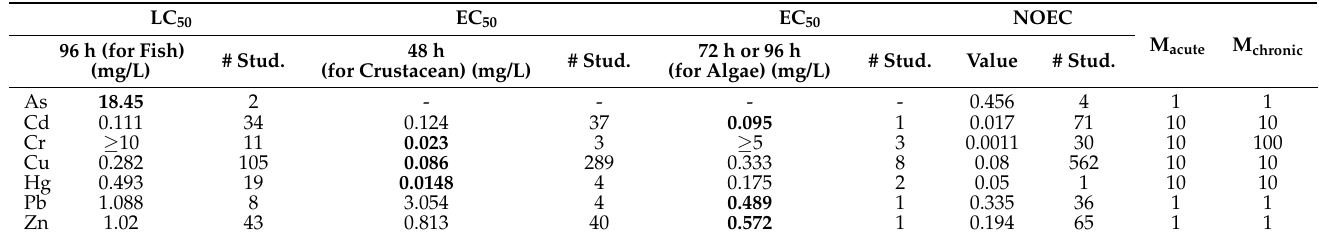
Table 6. Definition of M-factors for highly toxic components, including required parameters.